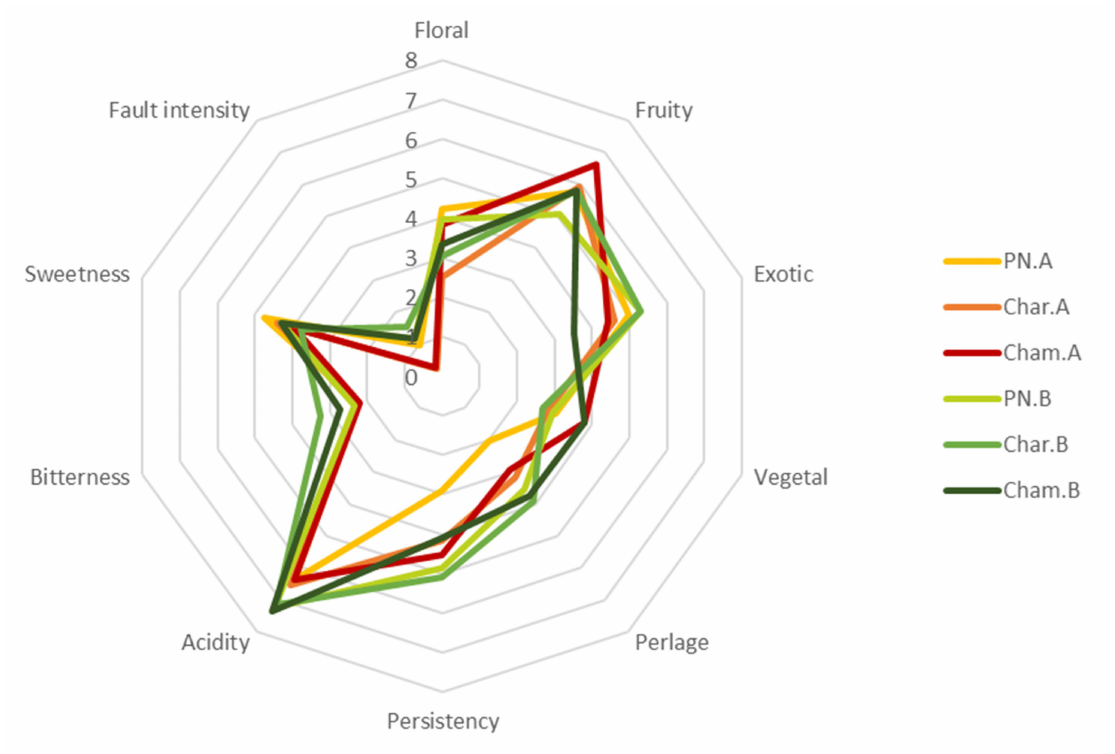
Figure 6. Sensory analysis aroma profile of the final products. PN = P é t-Nat, Char = Charmat method, and Cham = Champenoise method in cider produced after inoculum with Torulaspora delbrueckii strain A (A) or strain B (B). The attributes were assessed on a continuous scale from 0 to 10, with 0 being the lowest and 10 the highest score. Perlage: effervescence intensity; persistency: effervescence